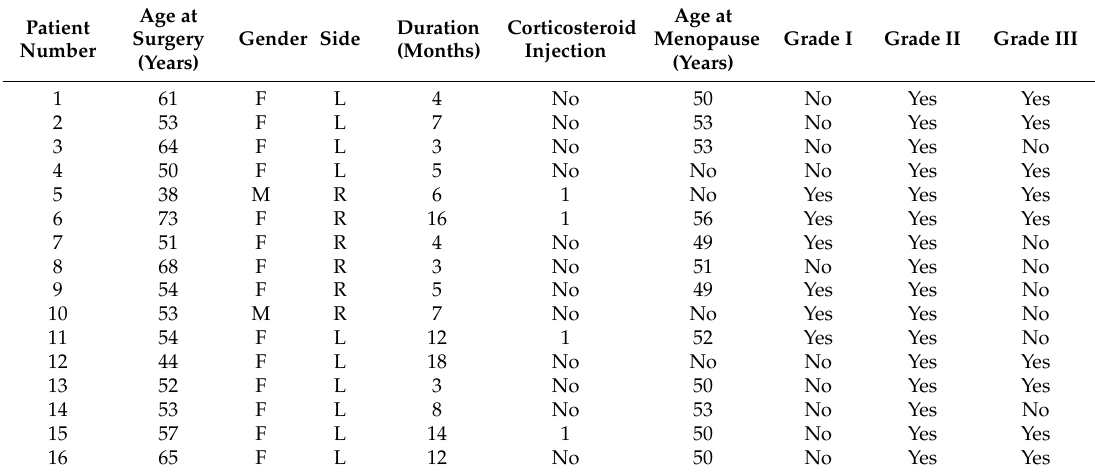
Table 1. Demographic data and histological grading of patients with de Quervain’s disease.